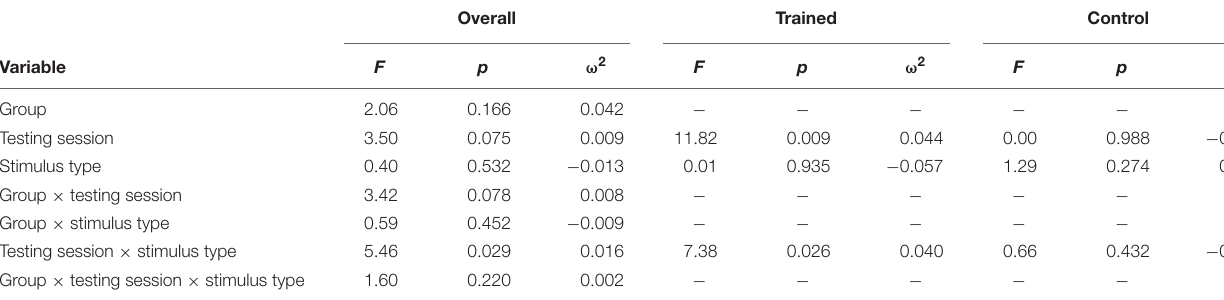
TABLE 6 | Results of P3b amplitude at FCz repeated measures ANOVA.